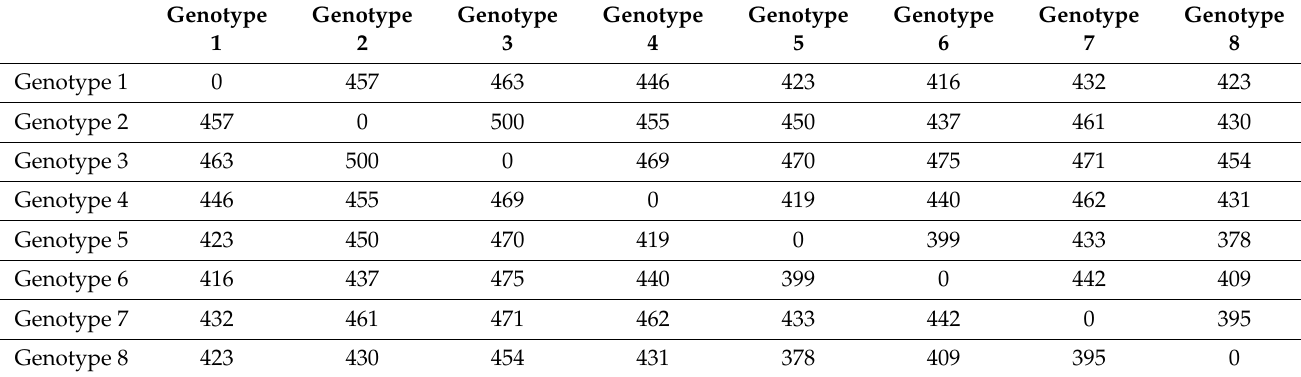
Table 2. Tree edit distance analysis: tree edit distances between the eight HDV